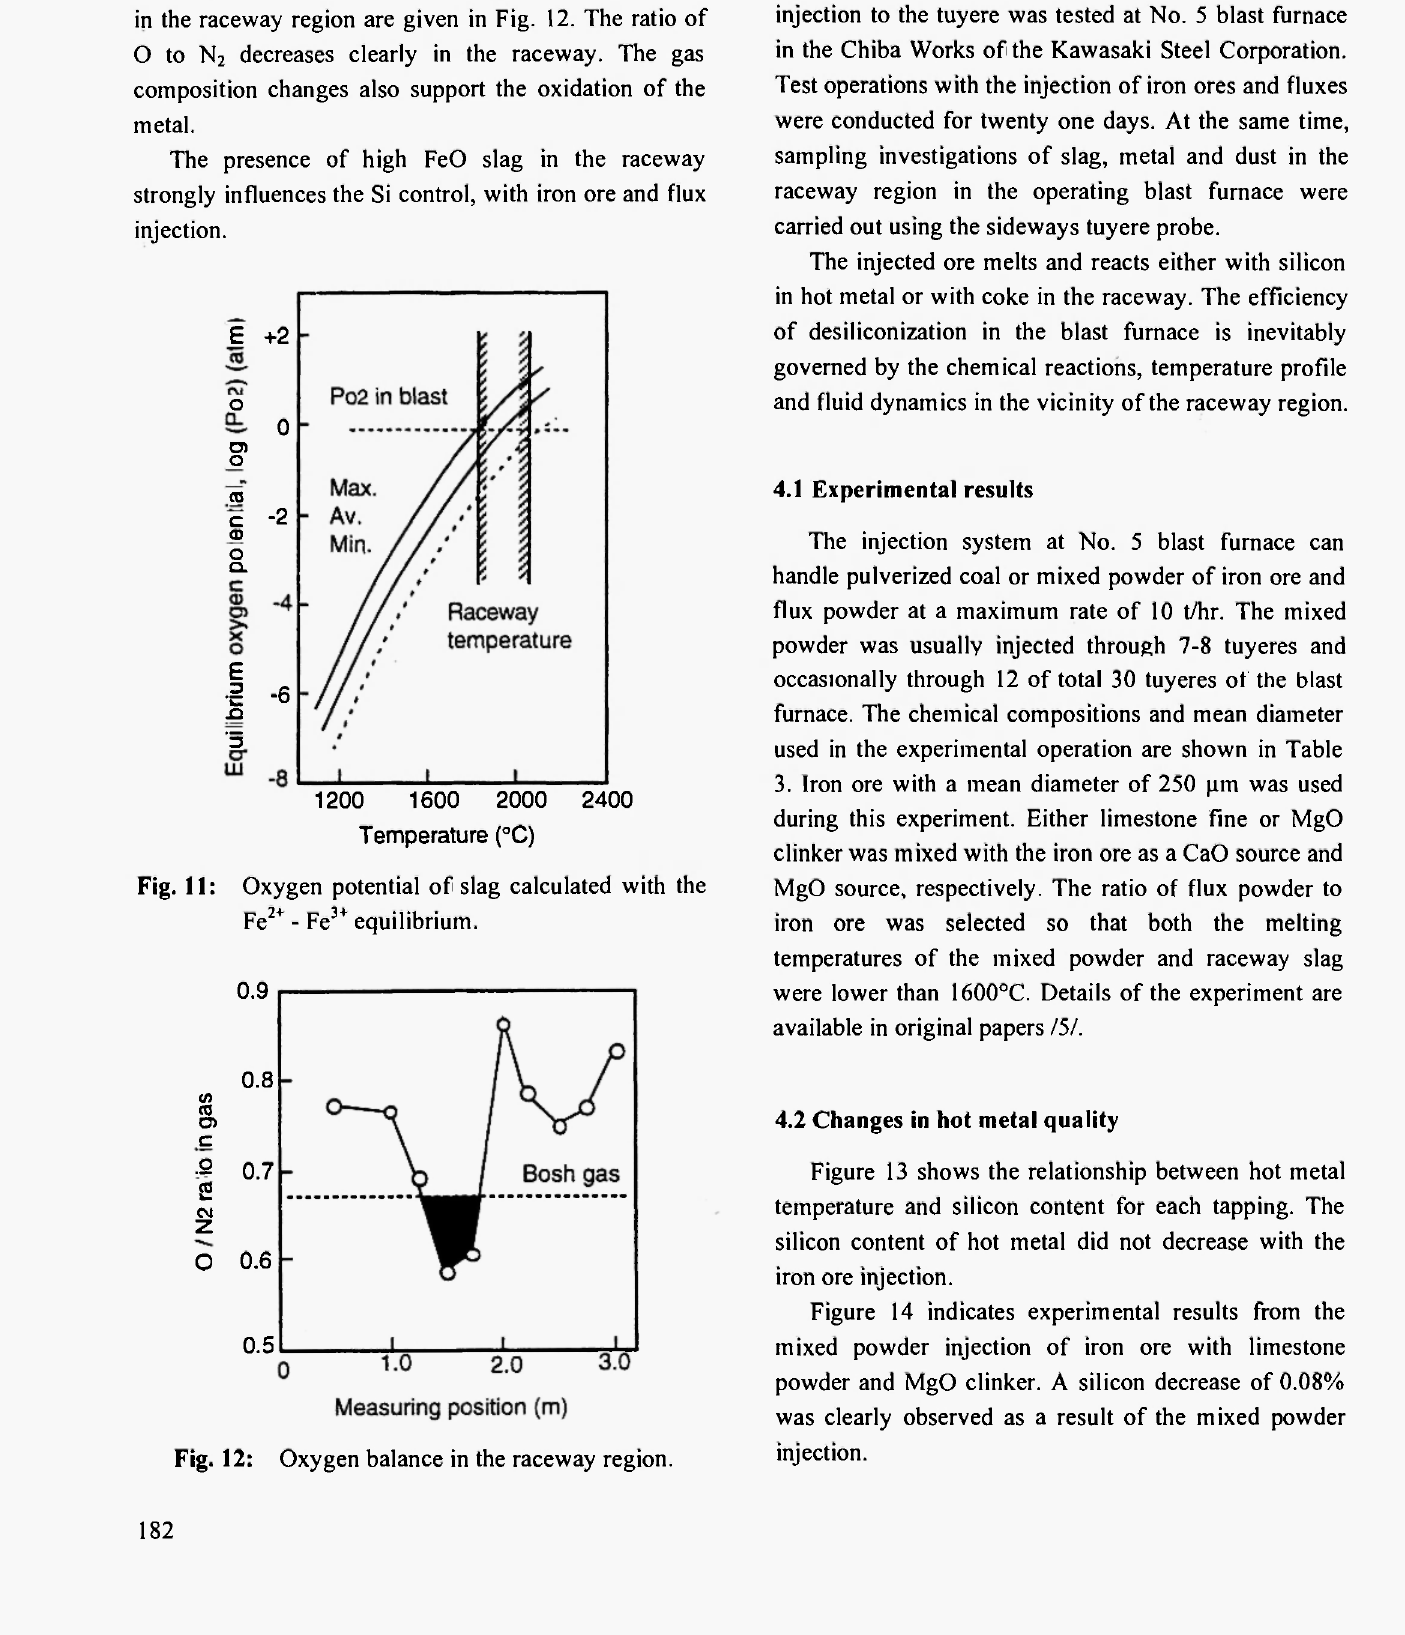
Fig. 12: Oxygen balance in the raceway region.